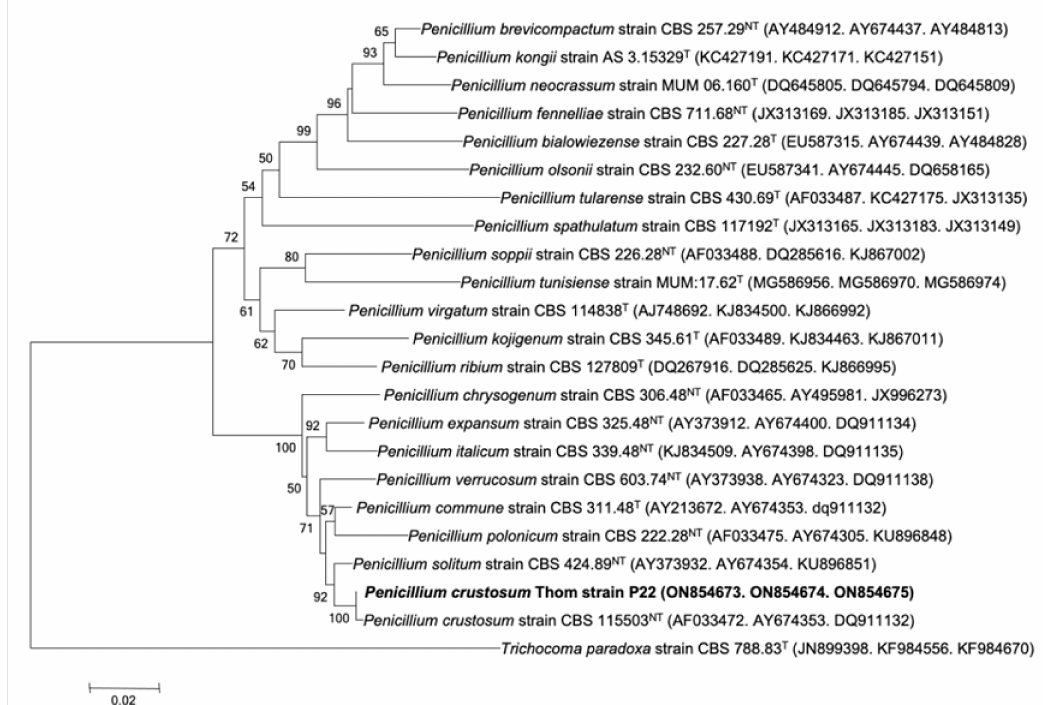
Figure 1. Strain P22 identification. Phylogenetic tree based on the combined phylogeny for ITS 1-5.8S- ITS 2, benA , and cmd genes sequences showing the position of Penicillium crustosum Thom strain P22 within the cluster comprising Penicillium species. The sequences of Trichocoma paradoxa strain CBS 788.83 (GenBank accession no.: JN899398) were chosen as an outgroup. Bar, 0.02 substitutions per nucleotide position. Numbers at nodes (>50%) indicate support for the internal branches within the tree obtained by bootstrap analysis (percentages of 100 bootstraps). GeneBank accession numbers are presented in parentheses. T, ex-type strain; HT, holotype strain; NT, neotype